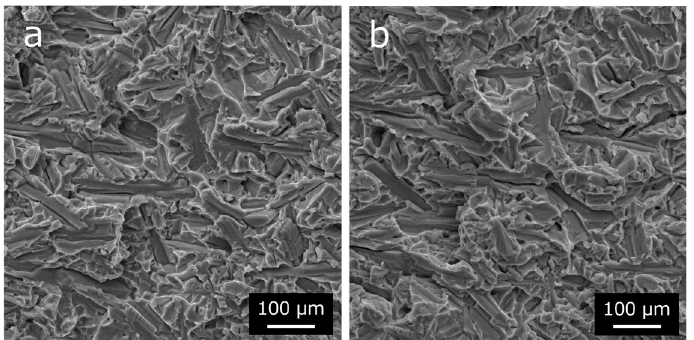
Figure 7. Pair of SEM fractographs for Ti6Al4V − 12.5 vol.% TiB composites; ( a ) normal image and ( b ) mirror-reversed image of opposite fracture surface of ( a ).